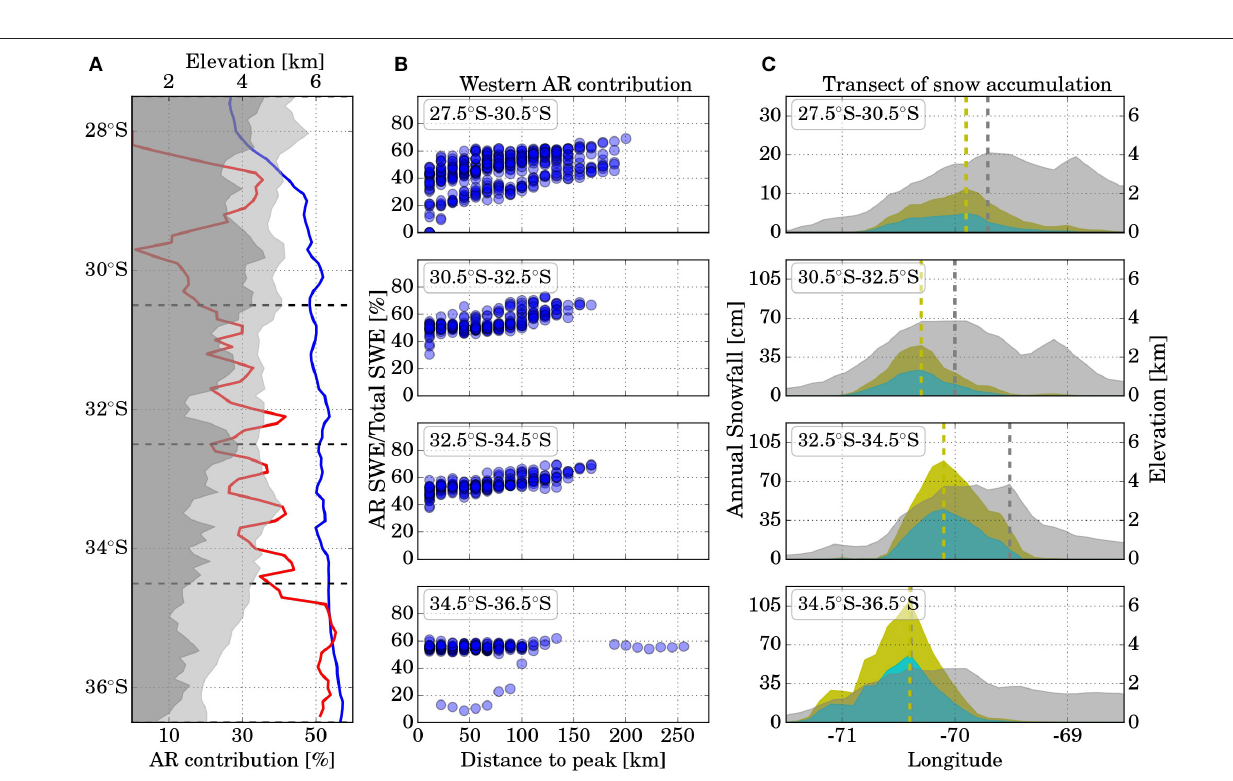
FIGURE 3 | (A) Variations with latitude (i.e., along-barrier direction) of the crestline (light gray), of the topographic altitude 40 km to the west (upwind) of the crest of the Andes (dark gray), and of the AR contribution to the annual snow accumulation on the western (blue line) and eastern (red line) slopes, respectively. Transects showing the variations in cross-barrier direction of (B) the AR contribution on pixel scales over the western (blue circles), and (C) the annual total (yellow) and AR-related (green) annual snow accumulation. The meridionally-averaged peak of the snow accumulation and of the maximum topographic elevation (crest) are shown as dotted yellow and gray lines,